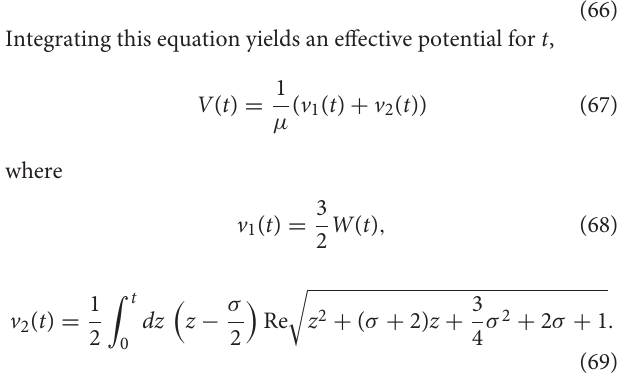
χ a which connect ¯